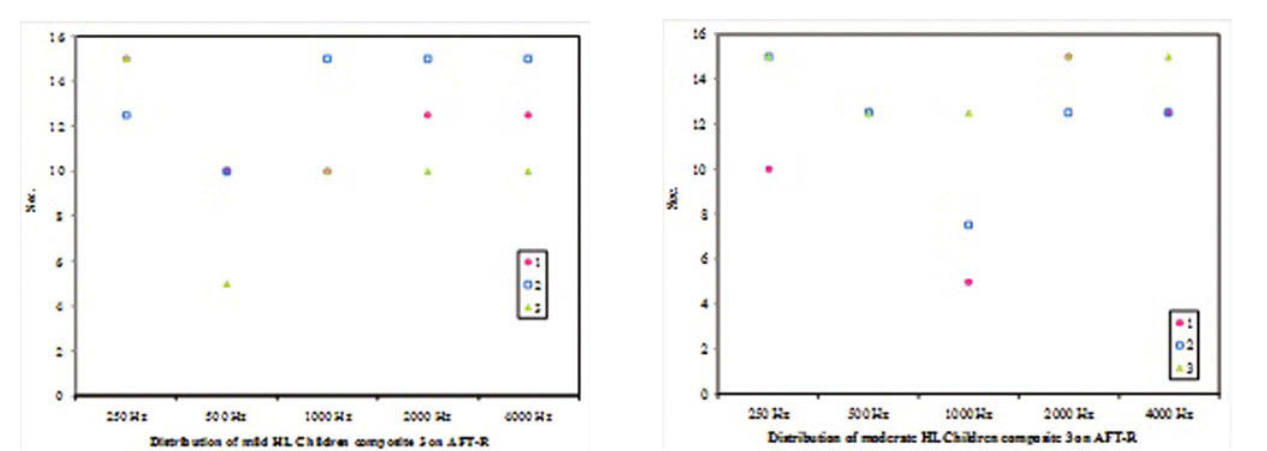
Distribution of the three children with moderate HL who have com- posite score 3 on